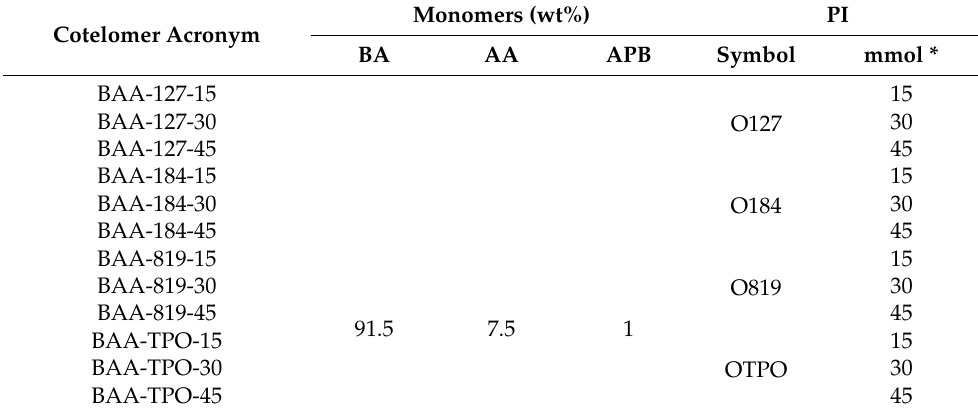
Figure 1. Schematic graph of UV-induced cotelomerization process with different type I radical photoinitiators. Table 2. Compositions of monomers, telogen, and photoinitiators for UV-induced cotelomerization process.